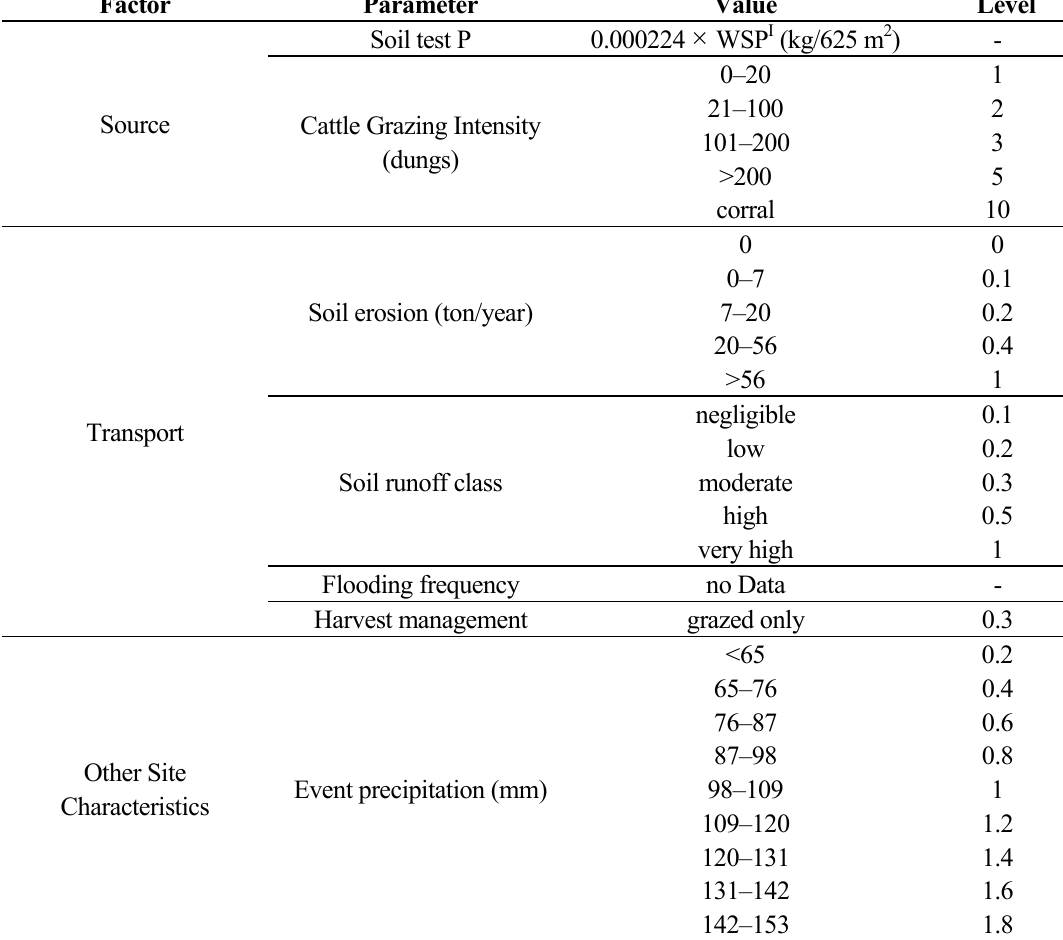
Table 2. Values of the Arkansas model's attributes. The values were modified to accommodate the Eastern Mediterranean conditions as follows: (1) soil test was changed to water-extractable P; (2) grazing density was used as an indicator for added P; (3) changes in precipitation depth; and (4) no best management option was